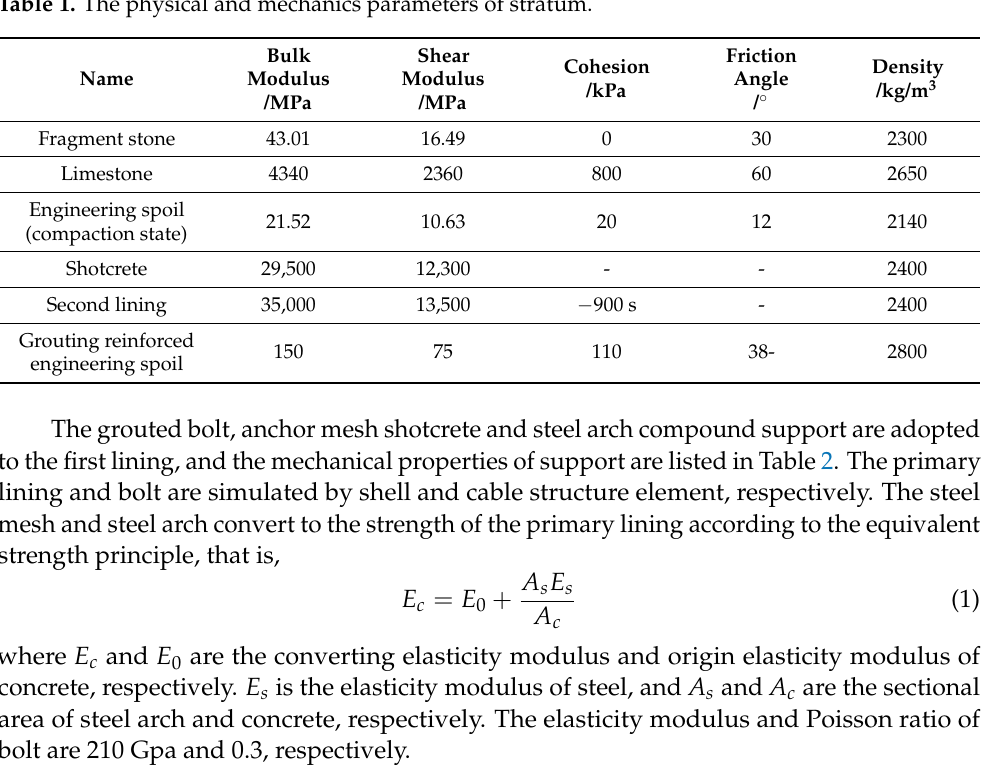
Figure 4. The numerical model of tunnel with ( a ) D3k279 + 888 section and ( b ) D3k279 + 938 section. Table 1. The physical and mechanics parameters of stratum.